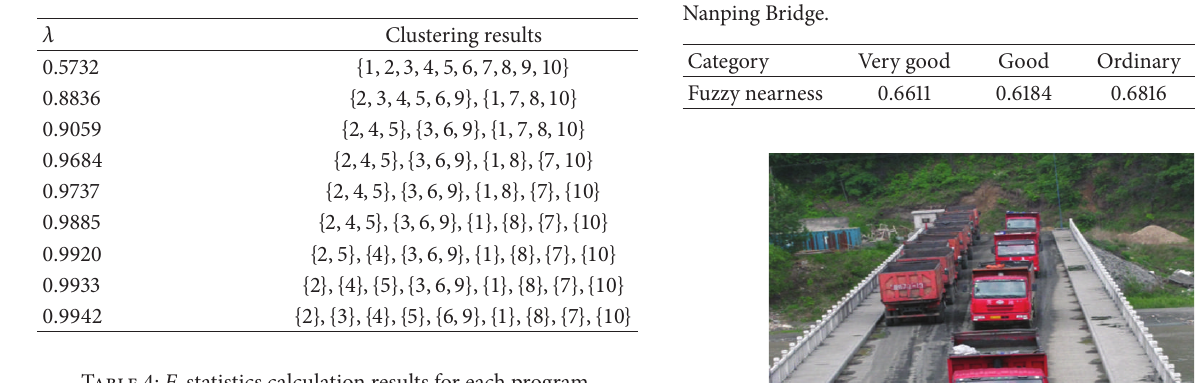
Table 3: Dynamic clustering results using different thresholds.